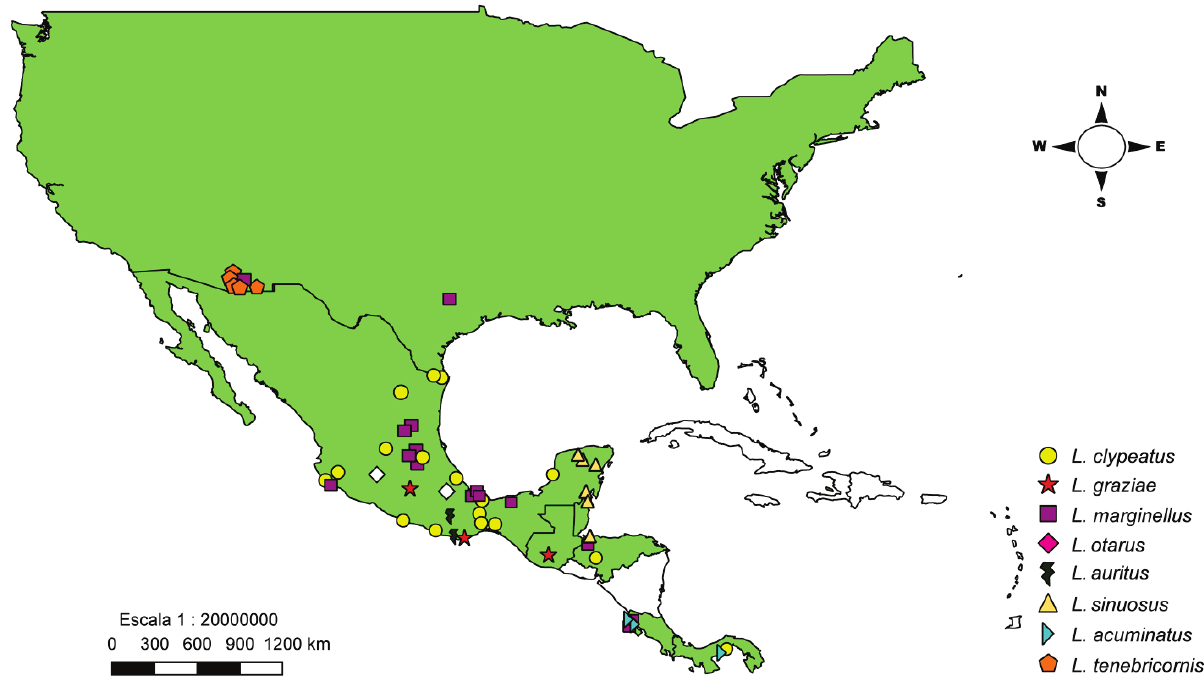
Figure 78. Distributional map for studied specimens of the species of Lineostethus . Countries with species records are in